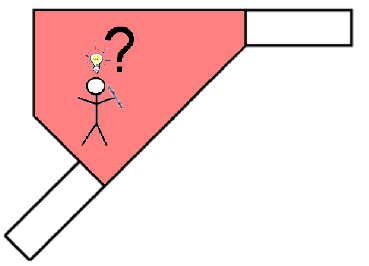
Fig. 3: Considered pentagon design domain